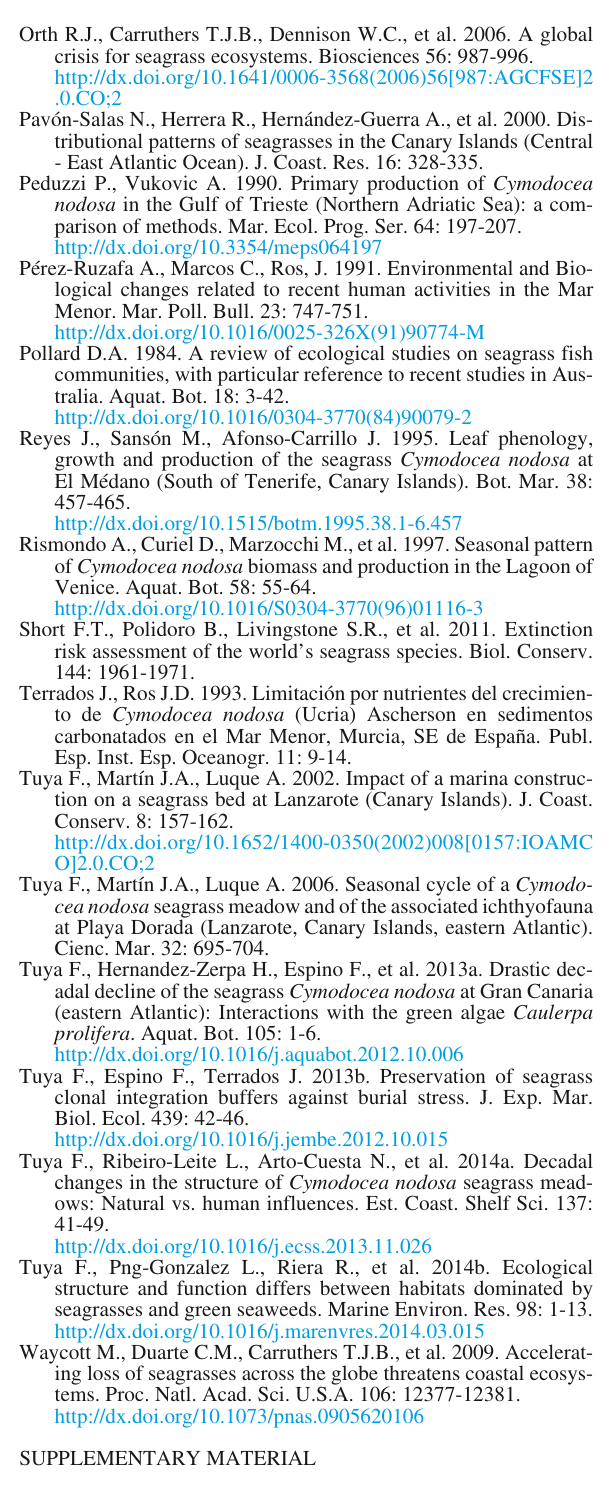
Table S1. – Compiled demographic data of C. nodosa at each meadow and island, including shoot density, coverage and leaf length. The name of the study/project correspond to the official name, while the name of the enterprise/Admistration that pro- vided the data is in parenthesis, whenever